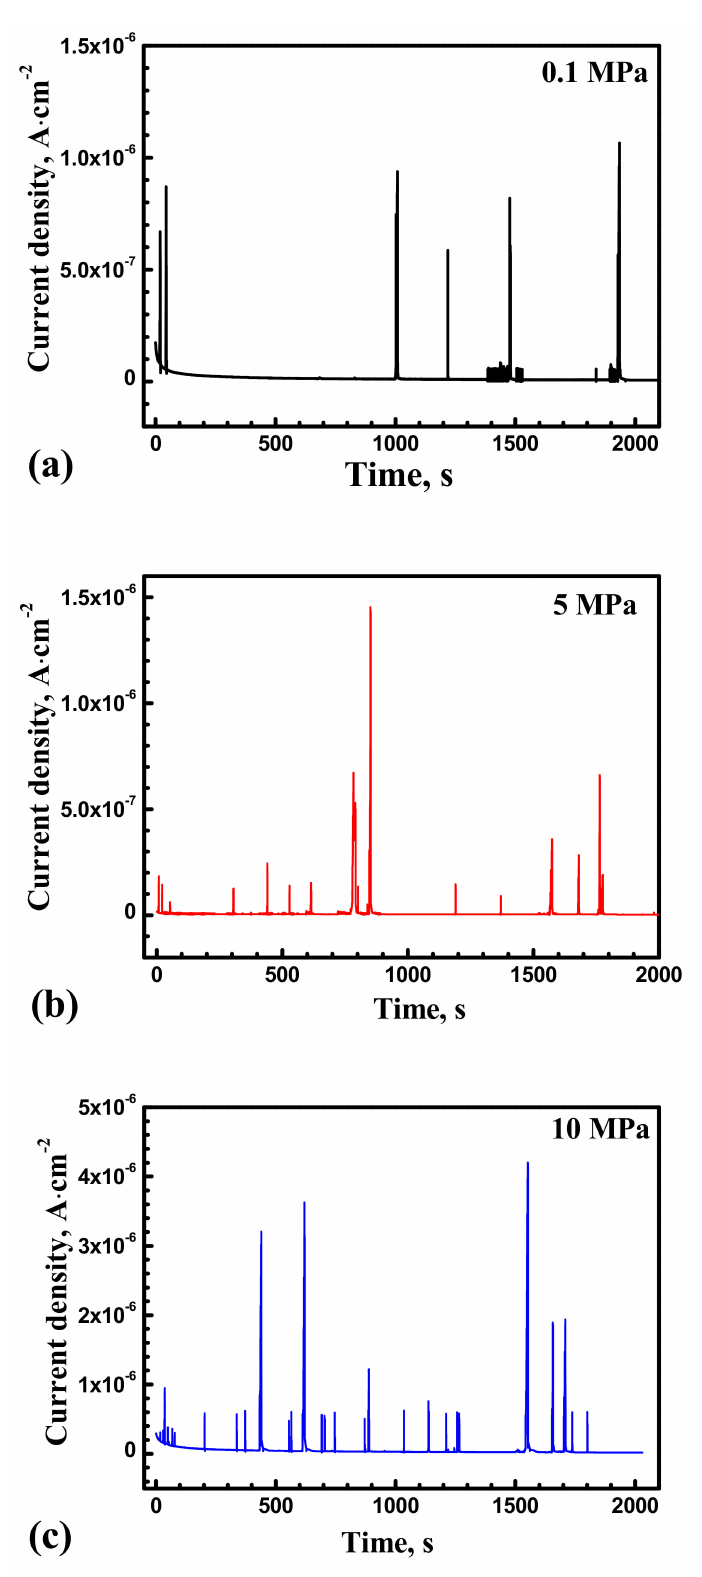
Figure 3. Typical current vs. time curves of the X70 steel at various hydrostatic pressure in 0.5 mol/L NaHCO 3 + 0.1 mol/L NaCl solution obtained under − 100 mV vs. Ag/AgCl electrode: ( a ) 0.1 MPa; ( b ) 5 MPa; ( c ) 10